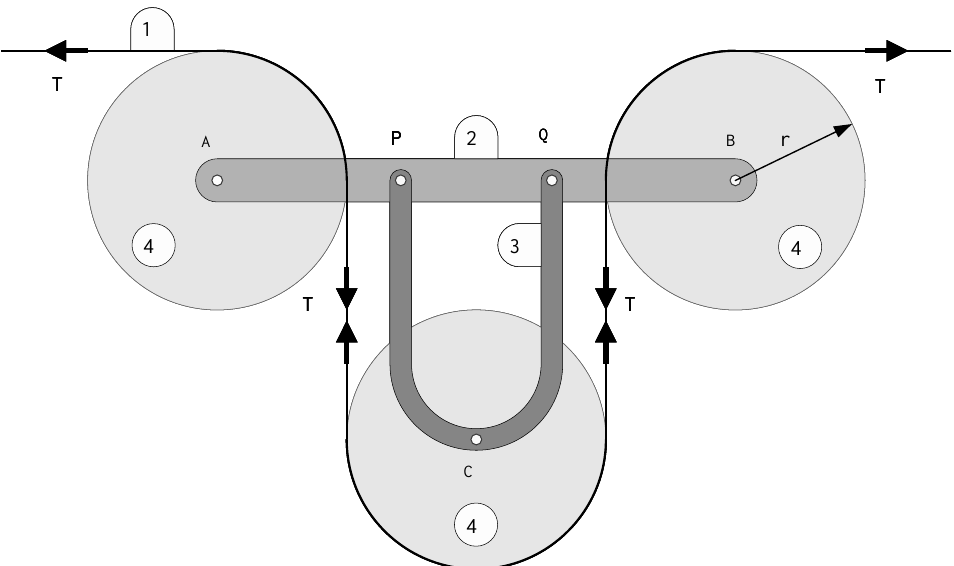
Figure 5. Scheme of the cable tension-measuring device. T = cable tension, r = pulley radius, A,B,C = pulley centers, P,Q = connection points between bars 2 and